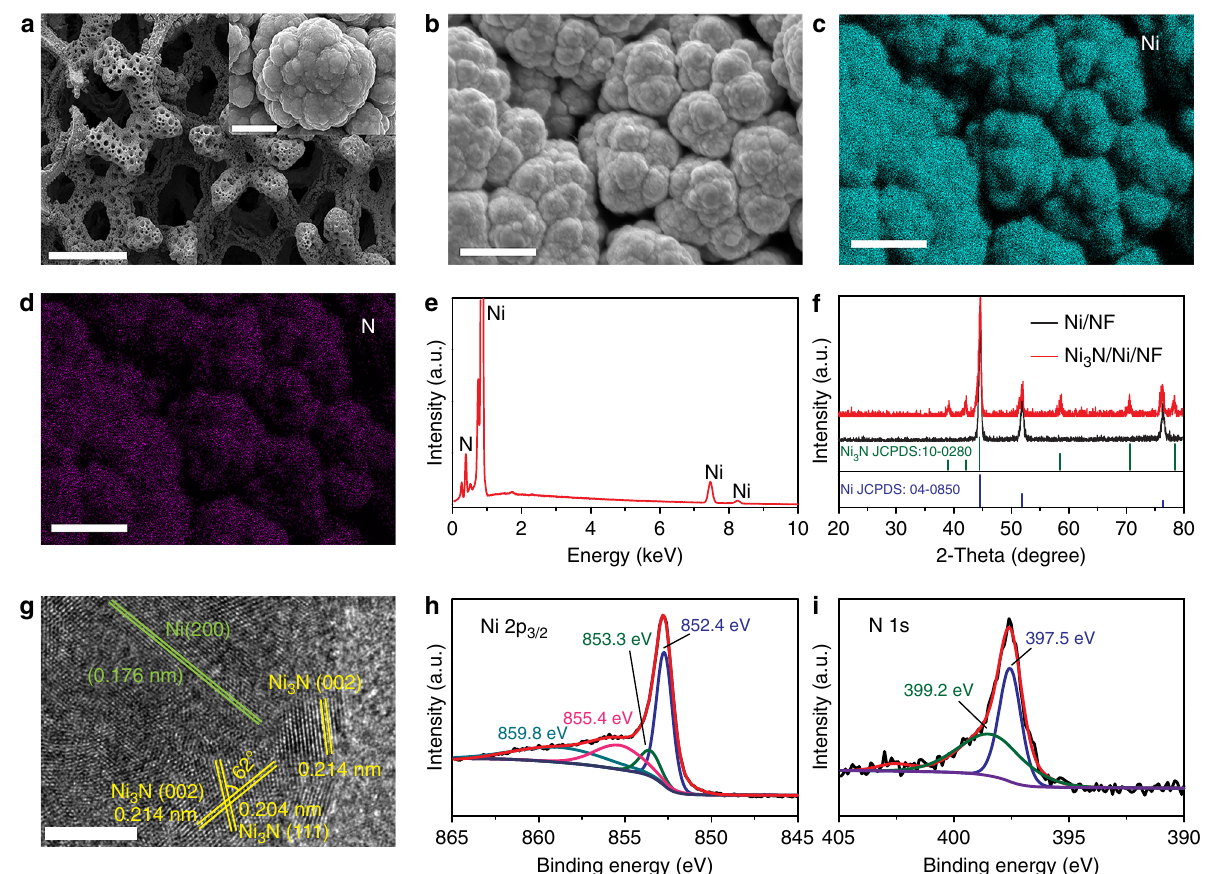
Fig. 1 Characterization of Ni 3 N/Ni interfacial electrocatalysts. a , b SEM images of Ni 3 N/Ni/NF at different magni fi cations. Elemental mapping images of Ni ( c ) and N ( d ). Scale bars, 500 µ m ( a ); 3 µ m inset of a ; 10 µ m ( b – d ). e EDX spectrum of Ni 3 N/Ni/NF. f XRD patterns of Ni 3 N/Ni/NF and Ni/NF. g HRTEM image of Ni 3 N/Ni interface. Scale bar, 5 nm ( g ). h , i XPS spectra of Ni 2p 3/2 ( h ) and N 1 s ( i